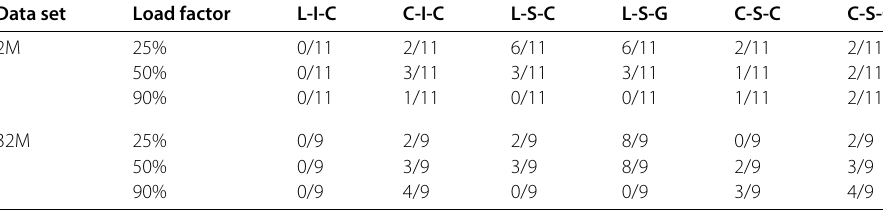
Table 2 The performance of Murmur hashing on data sets of different sizes Data